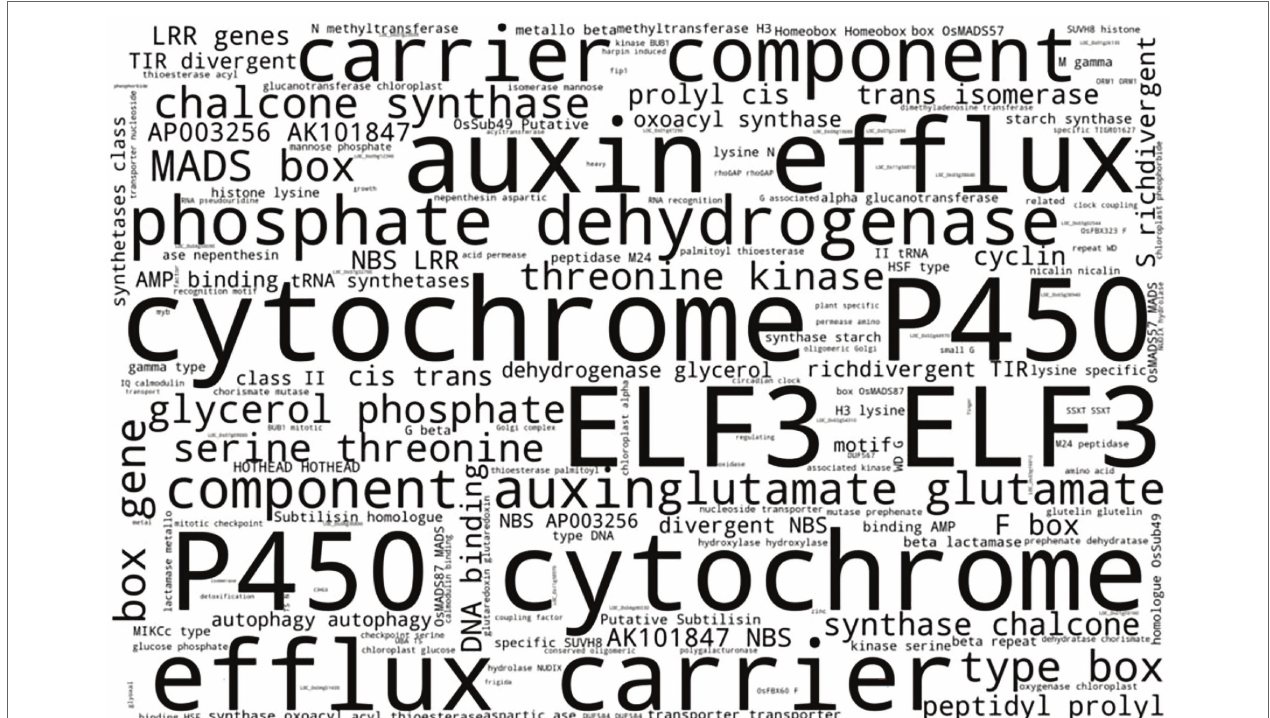
FIGURE 5 | Word cloud indicating most prominent terms from MSU GOSlim Assignment putative functions of LGHs among Thai NFVs. After removing technical terms, the most prominent gene functionality types include cytochrome P450 domains, auxin proteins, phosphate dehydrogenases, glutamate synthesis proteins, and chalcone synthases. See Supplementary Table S3 for full list.